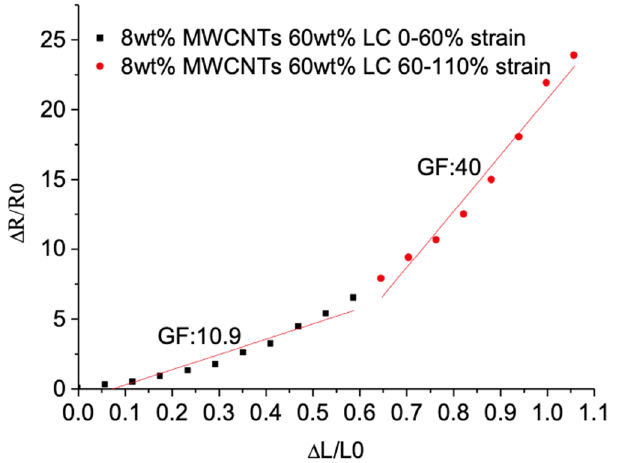
Figure 6. The relative resistance changes under different strain of the tensile sensor with 8 wt% MWCNTs and 60 wt% LC.